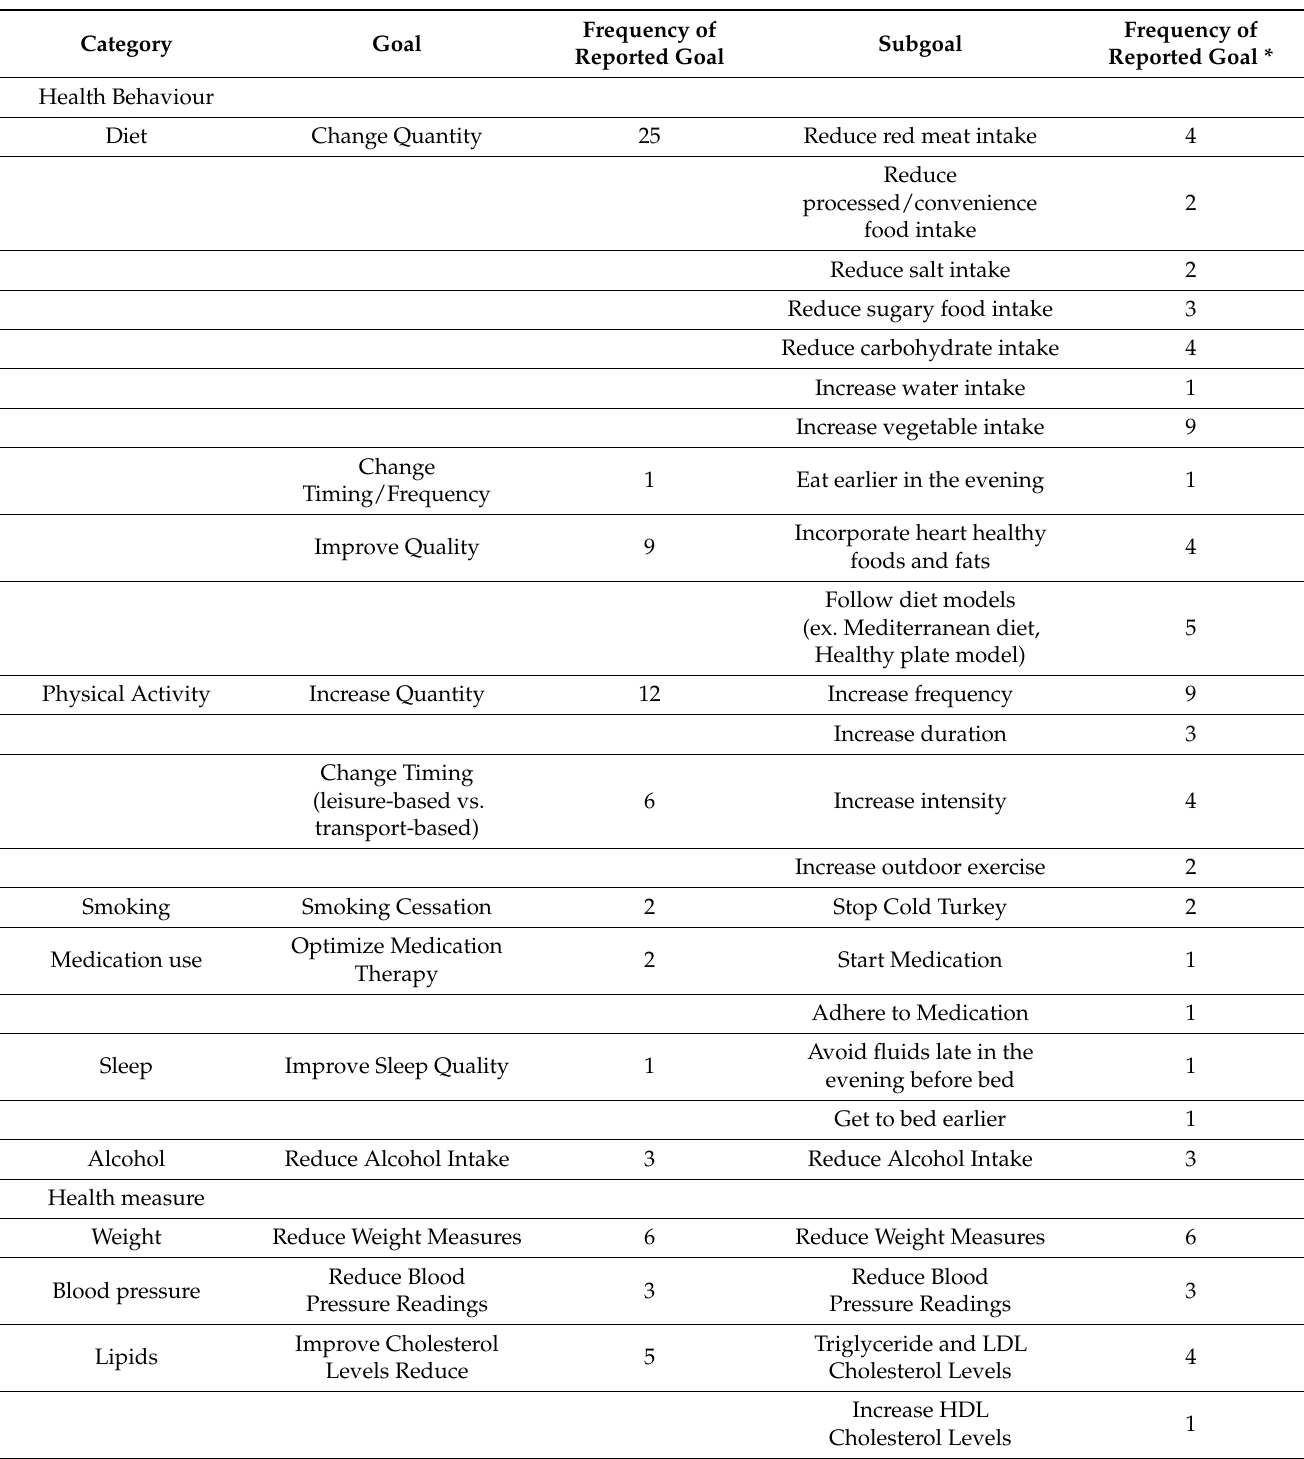
Table 2. Type and frequency of initial goals set by each patient at the start of the second pharmacist-led CVD prevention